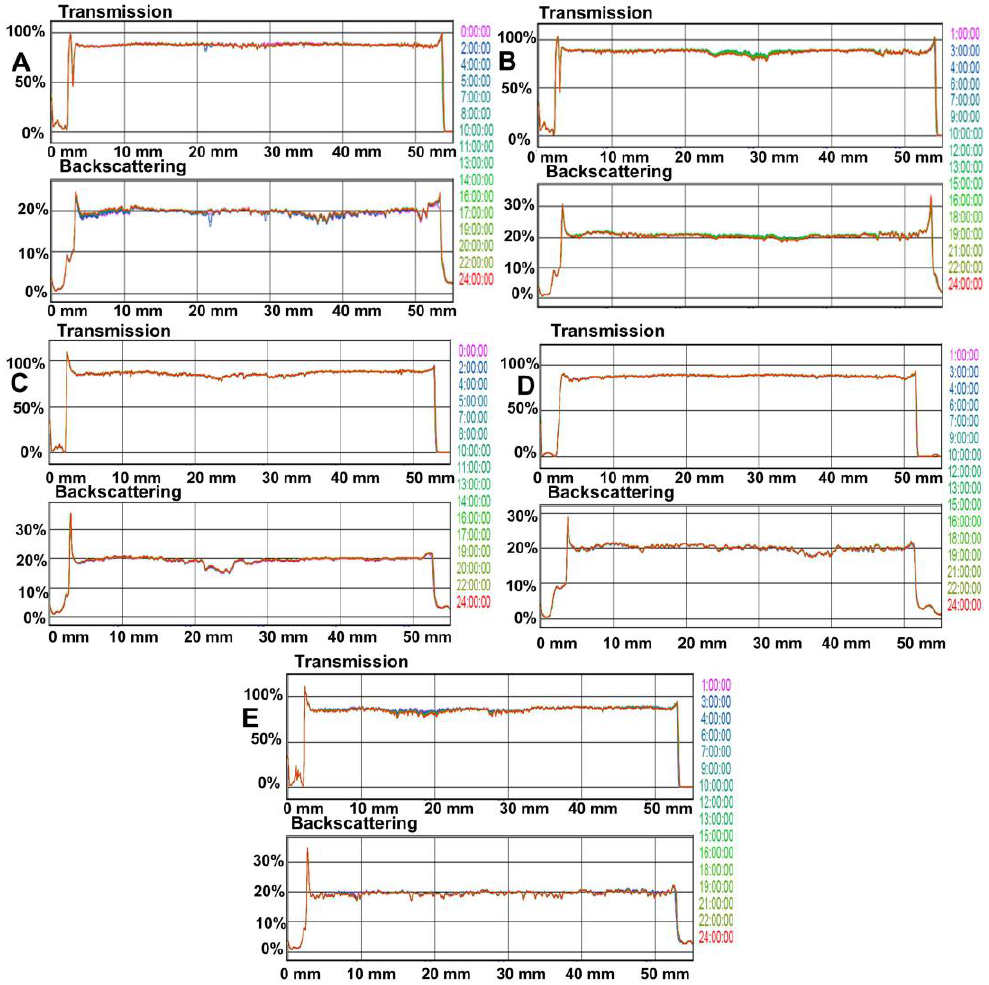
Figure 3. Transmission and backscattering profiles of polymeric solutions after 24 h ( t 0 ); ( A ) MCS01; ( B ) MCS02; ( C ) MCS03; ( D ) MCS04; ( E ) MCS05.